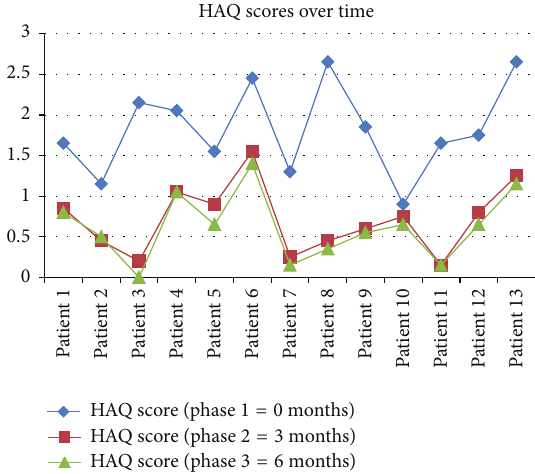
Figure 1: Illustration of the HAQ scores reported by patients at baseline, at 3 months, and 6 months following TNF- 𝛼 inhibitor therapy. Table 1: Analysis of HAQ